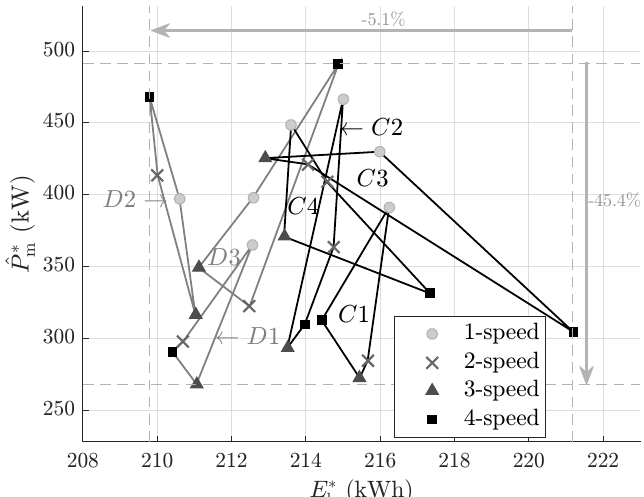
P m , plotted versus k = 1 k